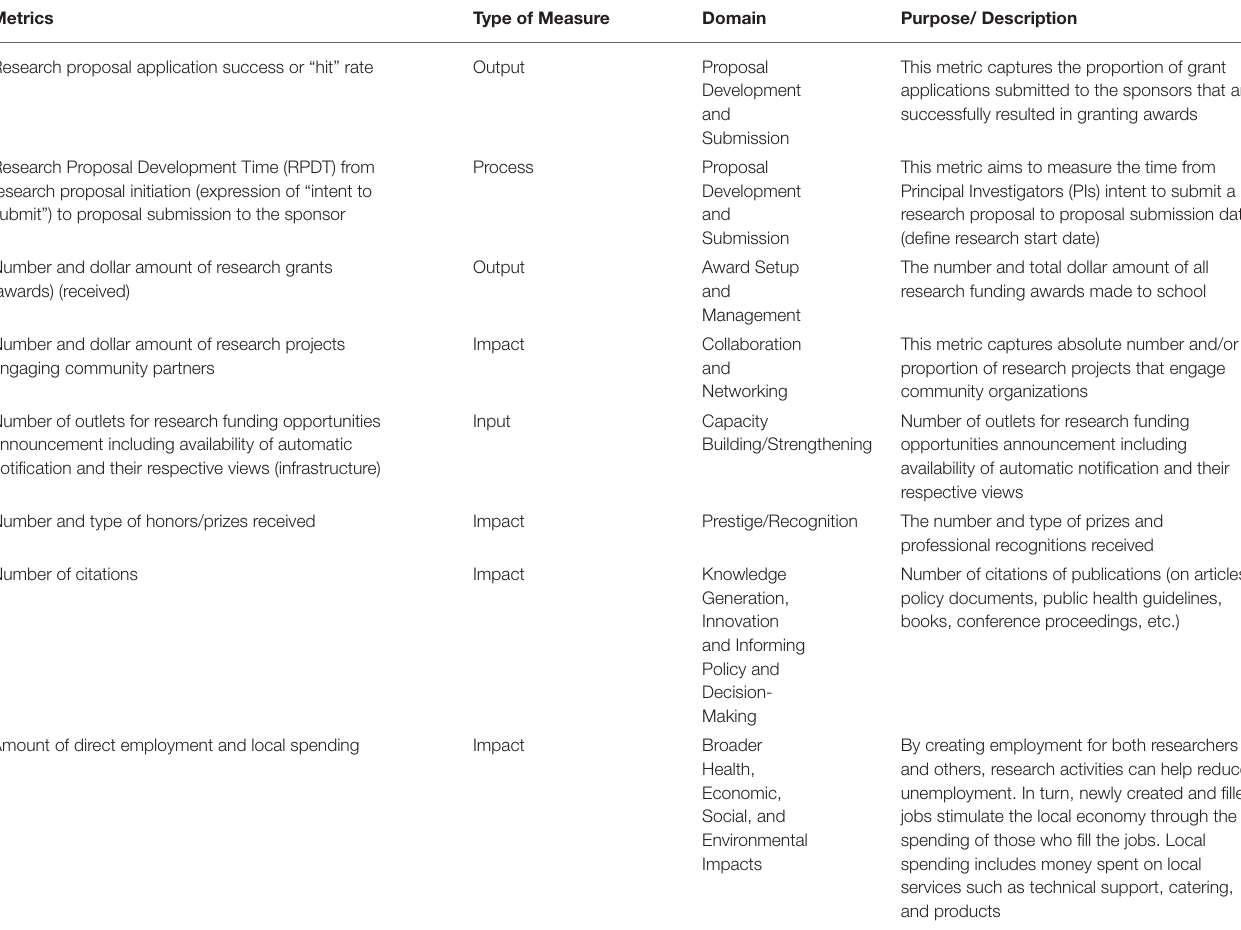
TABLE 3 | Research metrics portfolio (sample